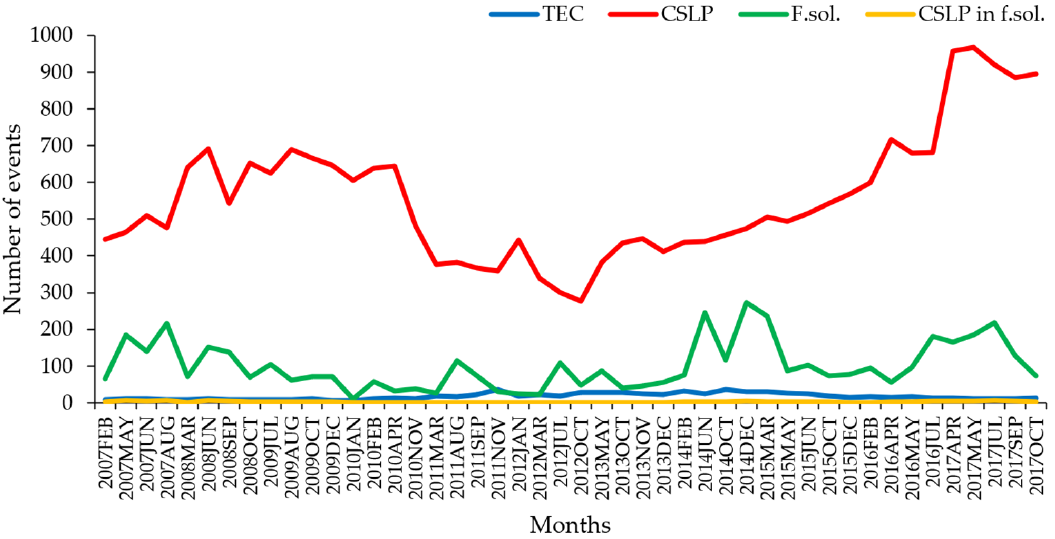
Figure 16. Mean TEC-max values, mean count of cycle slips, faulty solutions, and cycle slips at faulty solutions.